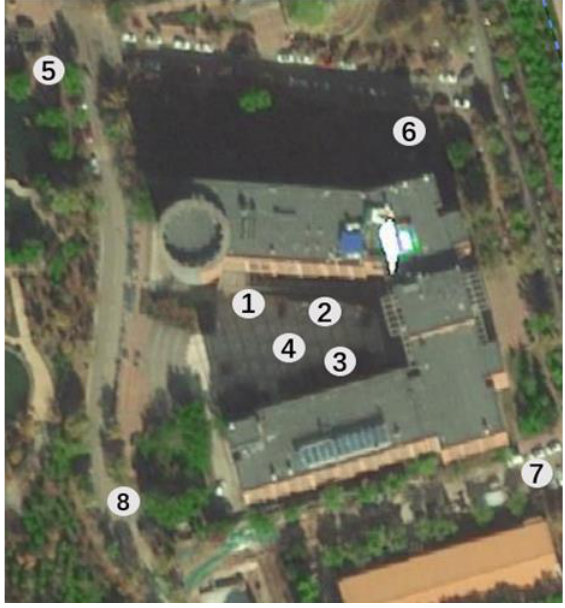
Figure 3. The location of measurement points in the target building and the surrounding area. Table 1. Surrounding environment of eight measurement points.